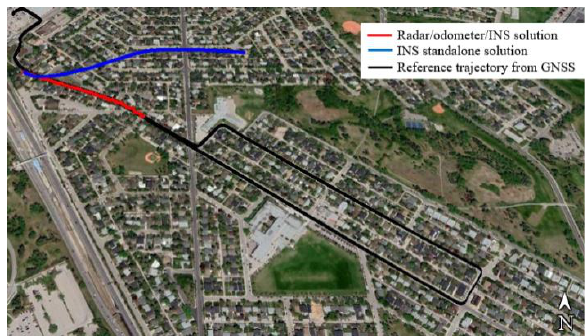
Figure 8. The estimated trajectory of the first test from Radar/odometer/INS integration during a simulated GNSS outage for 1-minute versus the reference trajectory from GNSS and the estimated trajectory from INS standalone solution. Table 2 shows RMSE for the horizontal position for different simulated GNSS outages outage durations for odometer/INS integration and Radar/odometer/INS navigation solution.